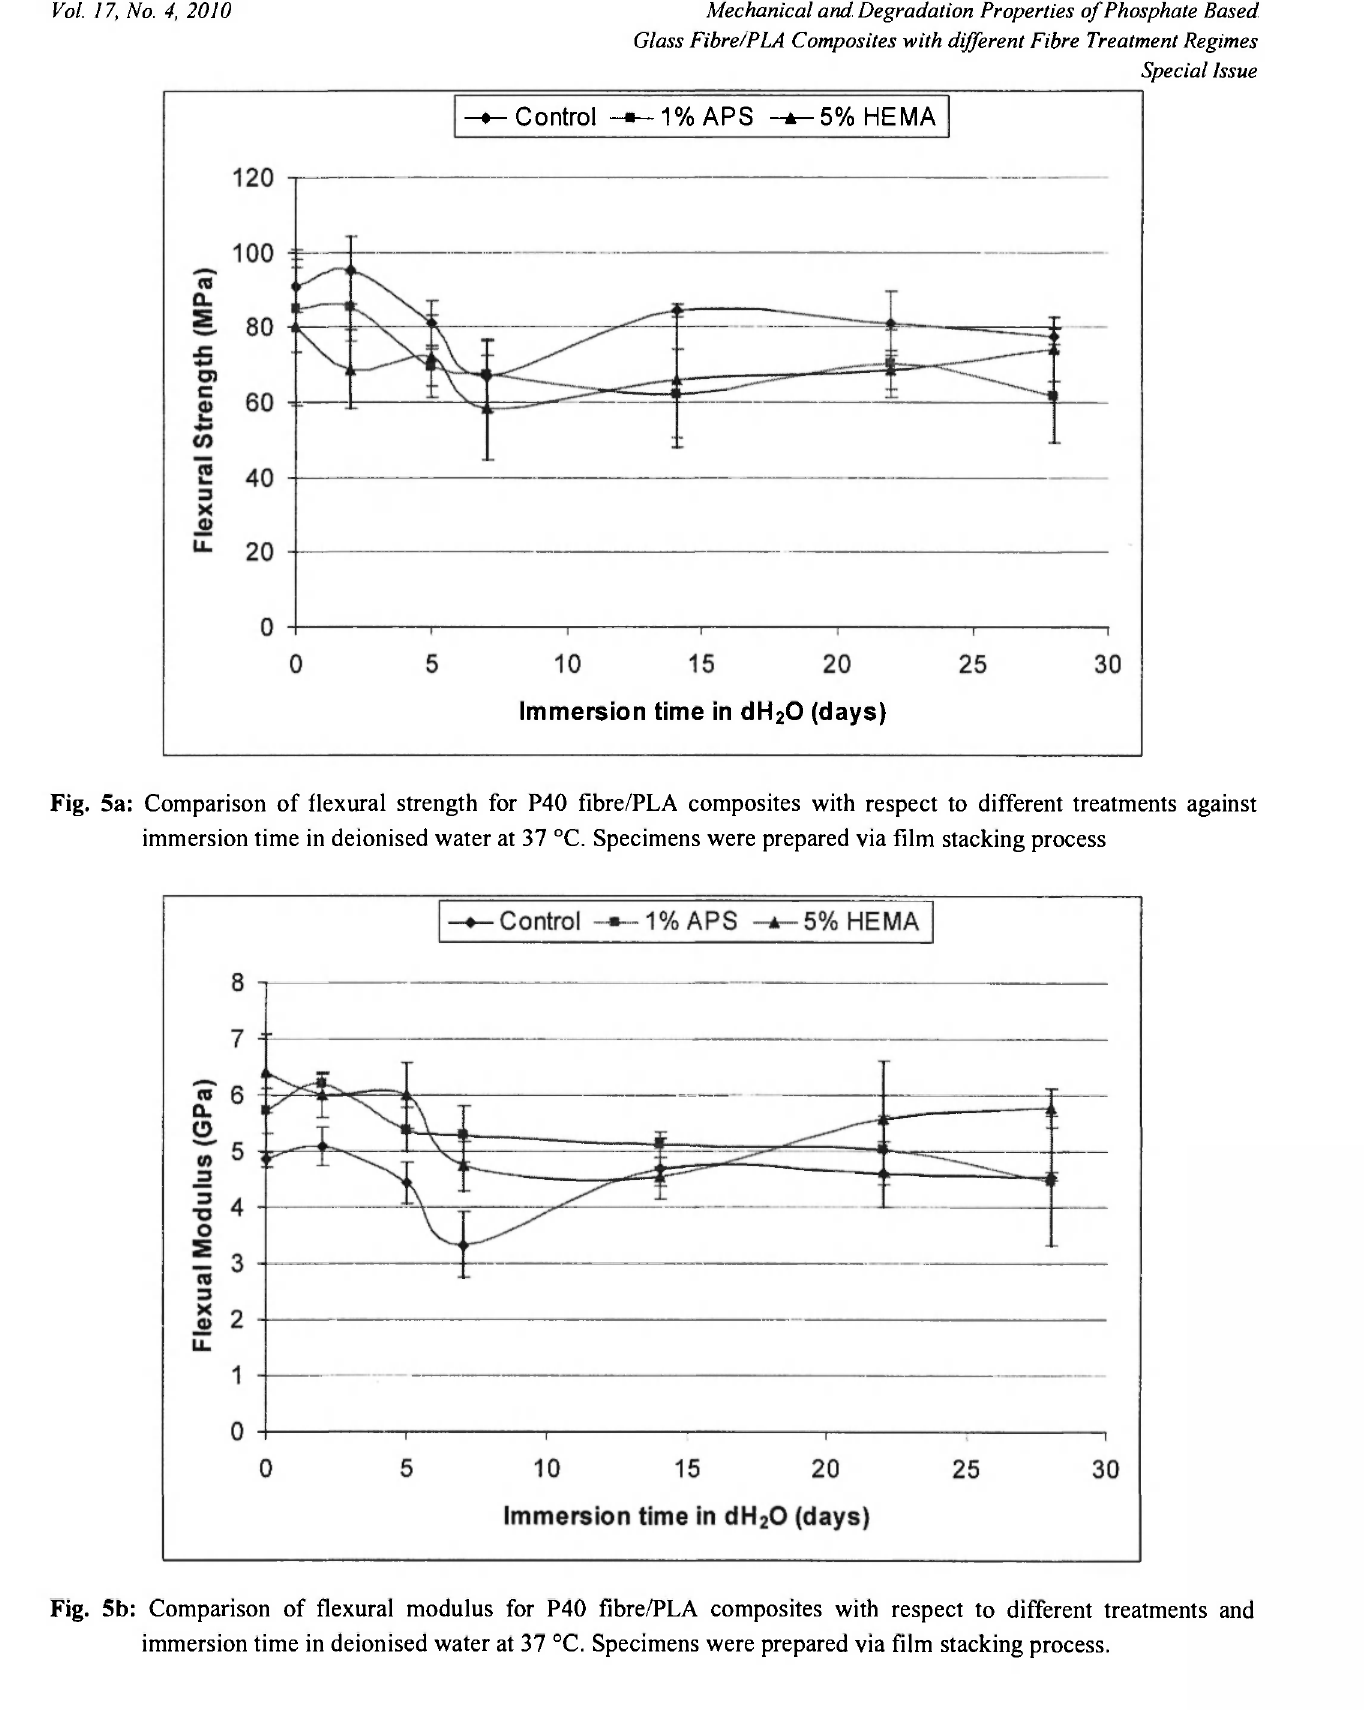
Fig. 5b: Comparison of flexural modulus for P40 fibre/PLA composites with respect to different treatments and immersion time in deionised water at 37 °C. Specimens were prepared via film stacking